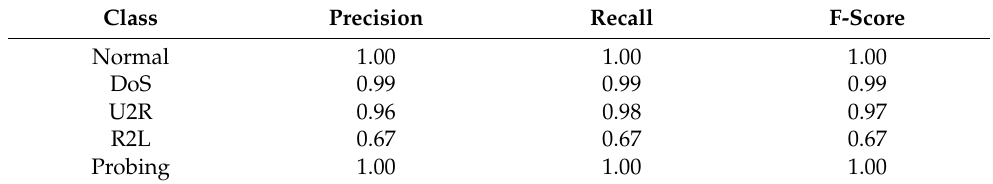
Table 8. DT-based anomaly detector’s traditional performance metrics recorded (multinomial classification). Class Precision Recall